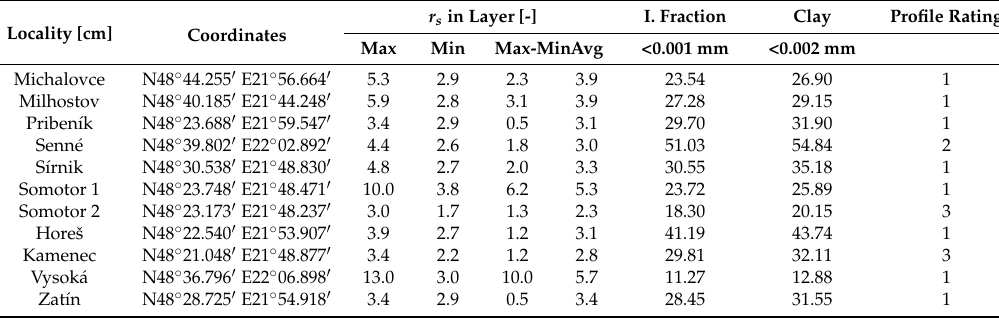
Table 3. Profile evaluation by the average r s